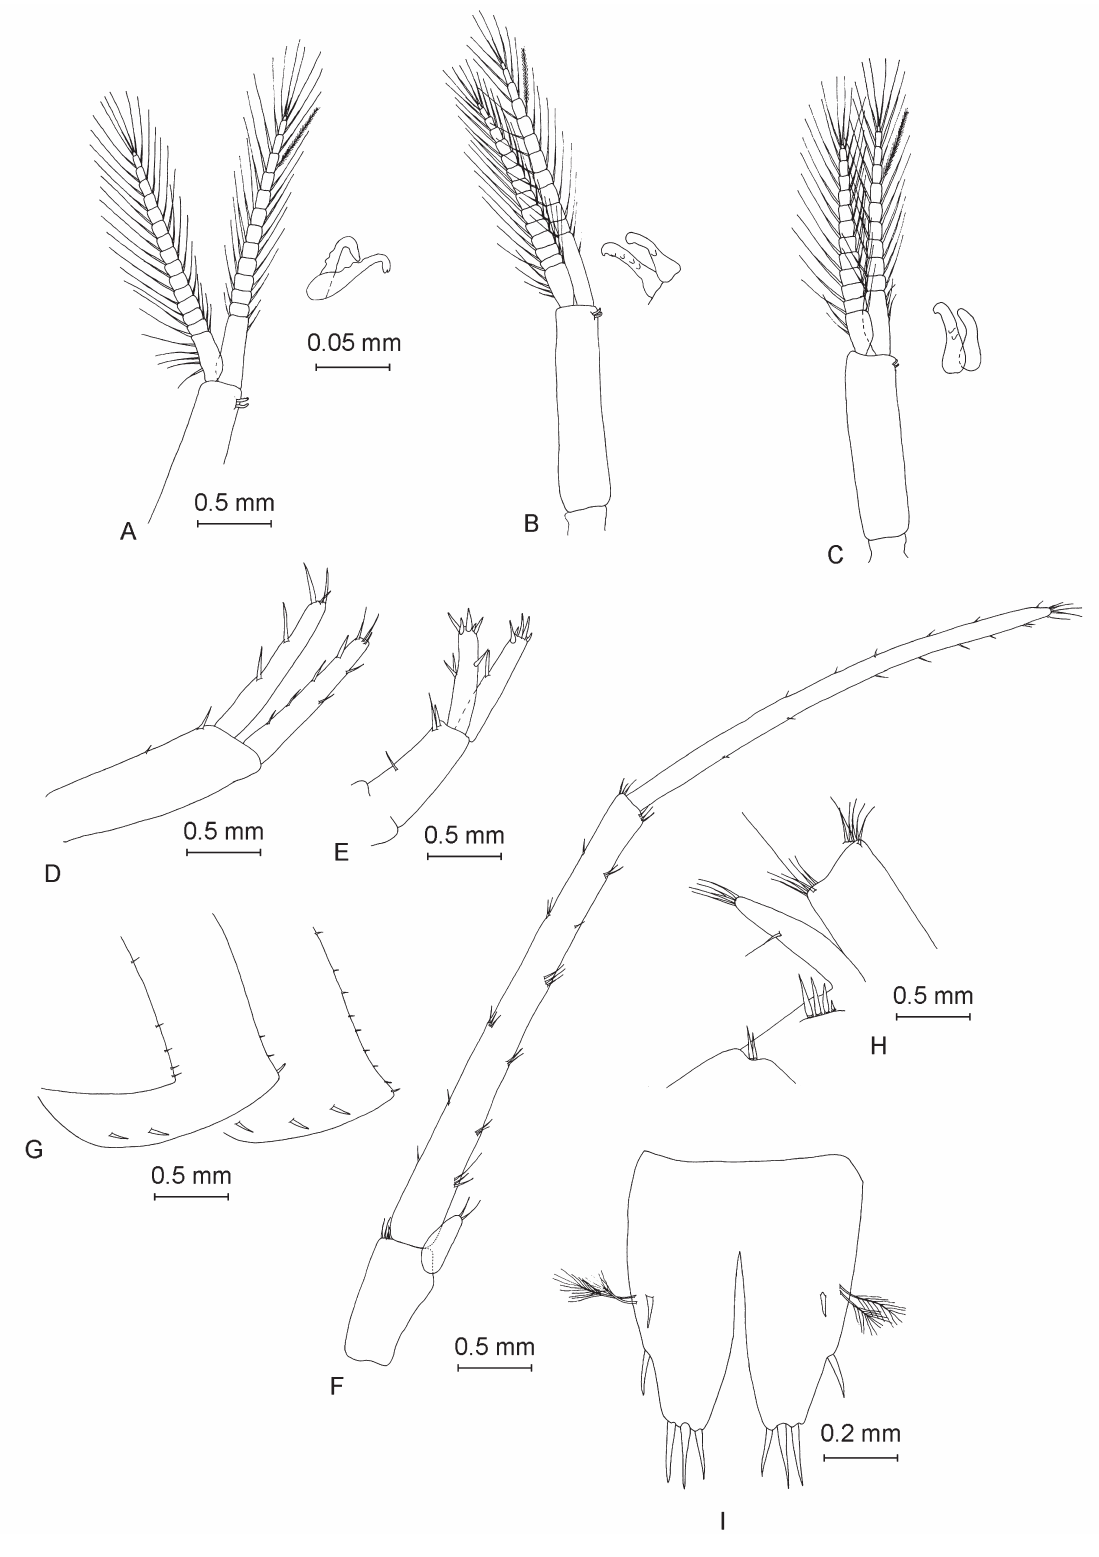
Fig. 8. ♂. — A–C . Pleopods with detail of retinacles A . Pleopod I. B . Pleopod II. C . Pleopod III. — D . Uropod I. E . Uropod II. F . Uropod III. G . Epimeral plates. H . Urosome of ♂ sampled from str. Horia, Cloşca şi Crişan13. I